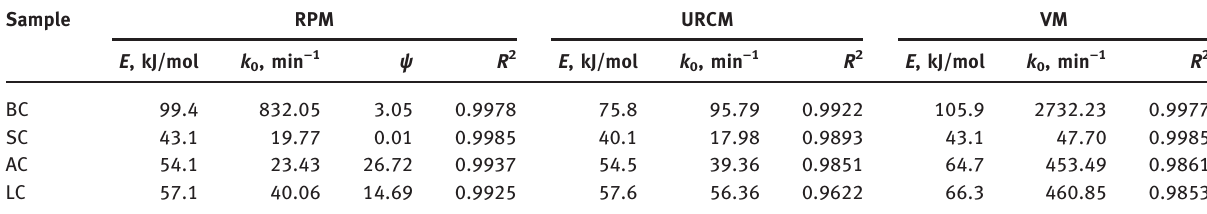
Table 3: Kinetic parameters under different heating rates for RPM, URCM and VM. Sample RPM URCM VM